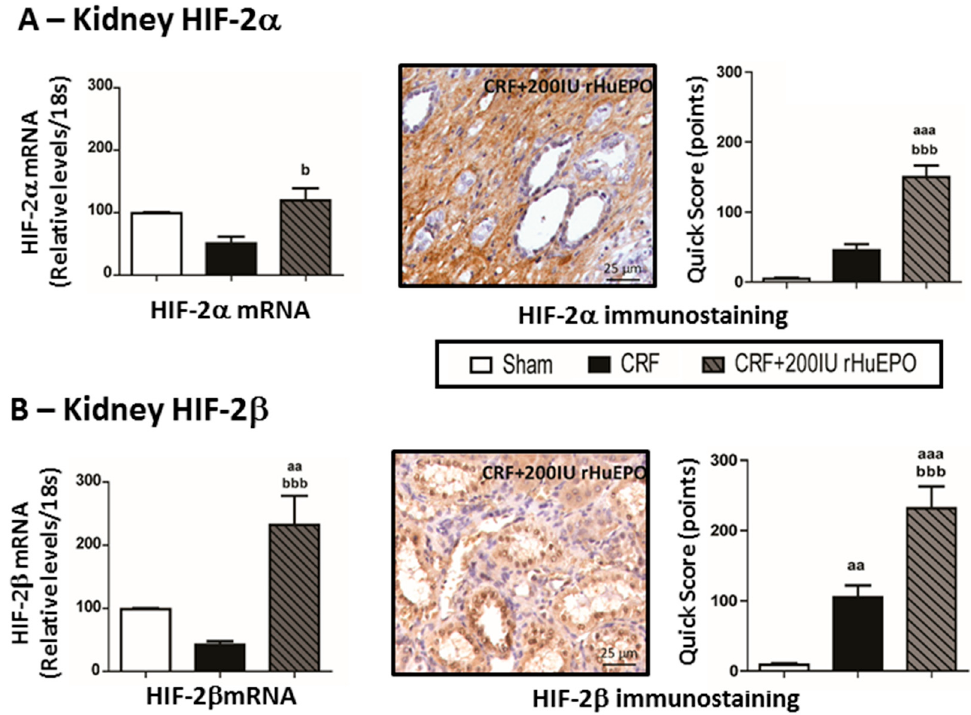
Figure 7. Kidney hypoxia-inducible factor 2 α ( A ) and 2 β ( B ). mRNA and protein (immunohistochemical staining) expression. Original magnification × 400. Results are presented as mean ± SEM (7 rats per group): aa: p < 0.01, and aaa: p < 0.001 vs. Sham; b: p < 0.05, and bbb: p < 0.001 vs. CRF.